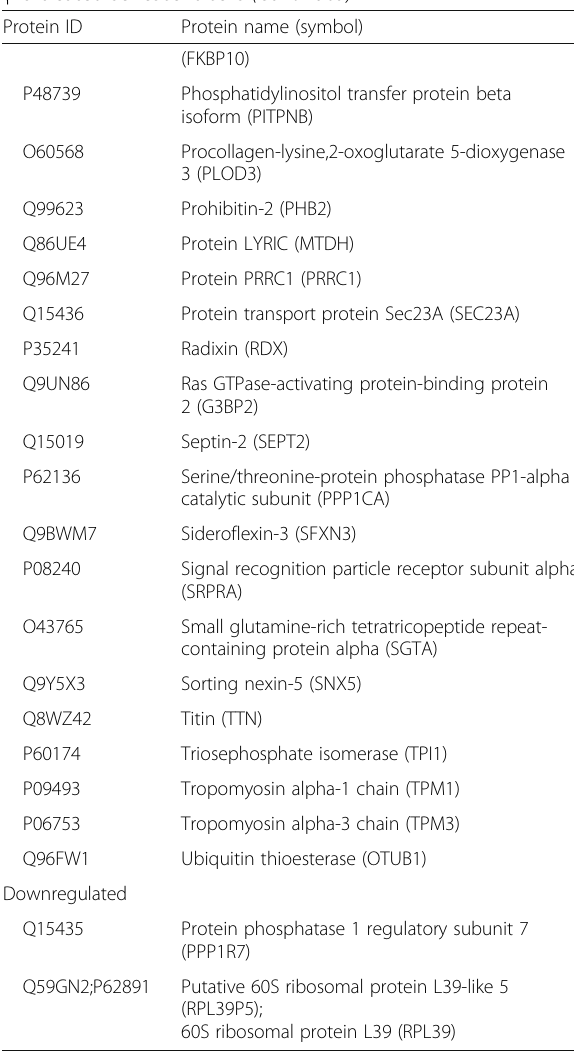
Table 2 List of differentially expressed proteins in vehicle- and γ T3-treated senescent cells